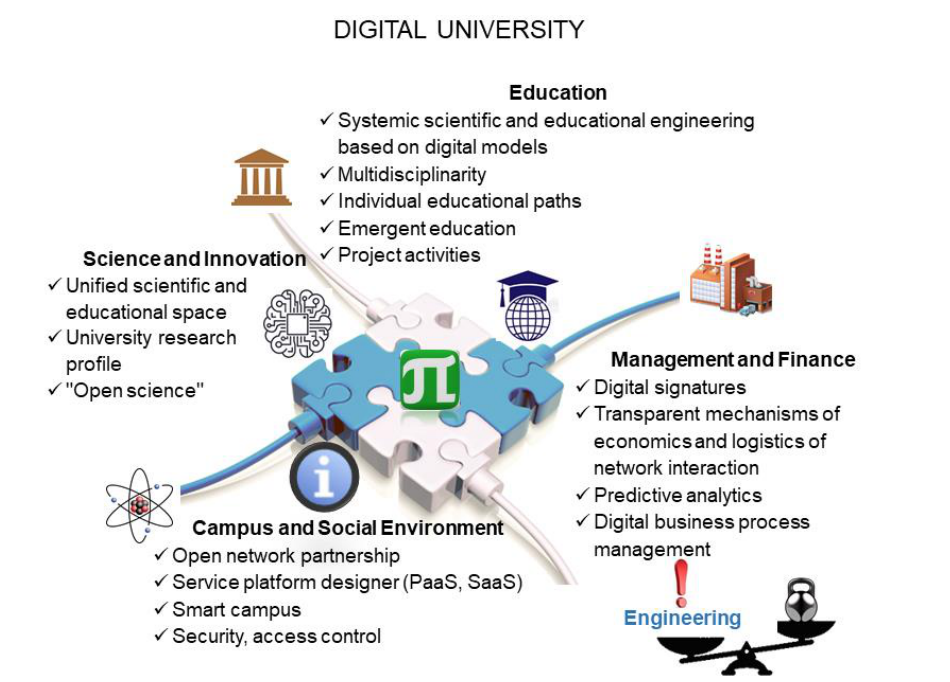
Fig. 1. Functional scheme of the Digital University model of